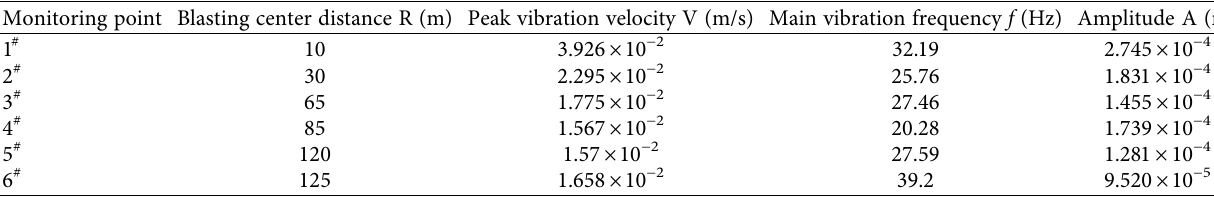
Figure 9: Comparison and verification of numerical simulation results. (a) Time-history curve of vibration velocity of each monitoring point in the model and (b) comparison curve of measured-simulated peak vibration velocity. Table 5: Numerical simulation results of vibration